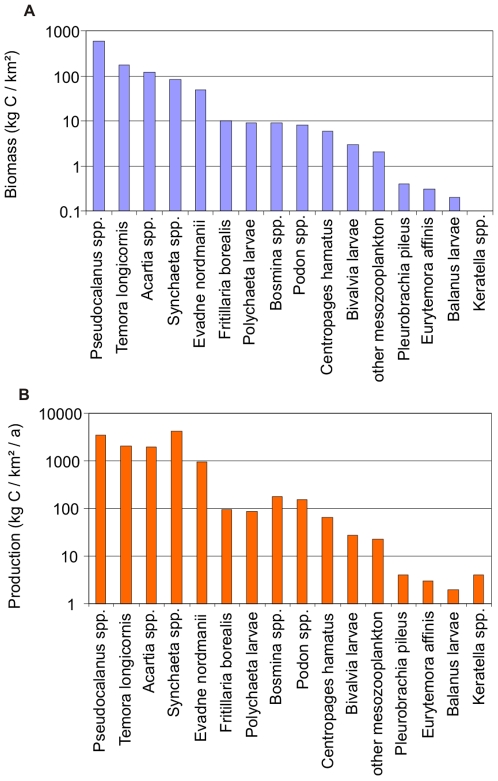
Annual zooplankton (A) biomass and (B) production by taxa in Gdansk Bay in the 1980s (modified from [196]).